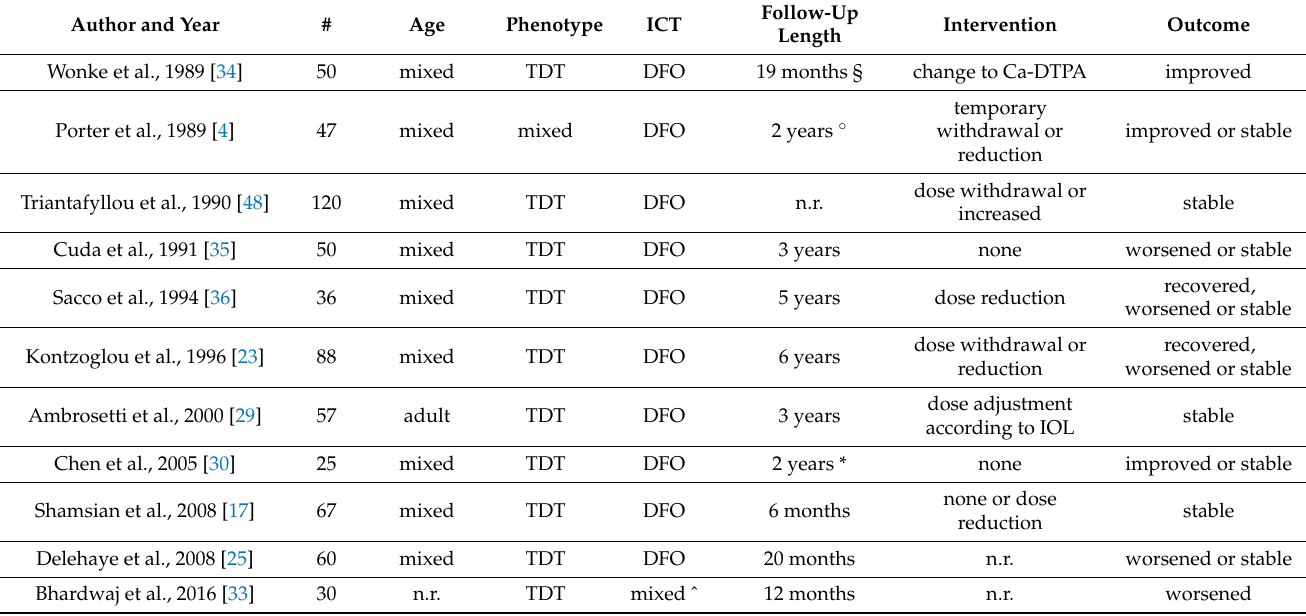
Table 2. Longitudinal studies and outcome at follow